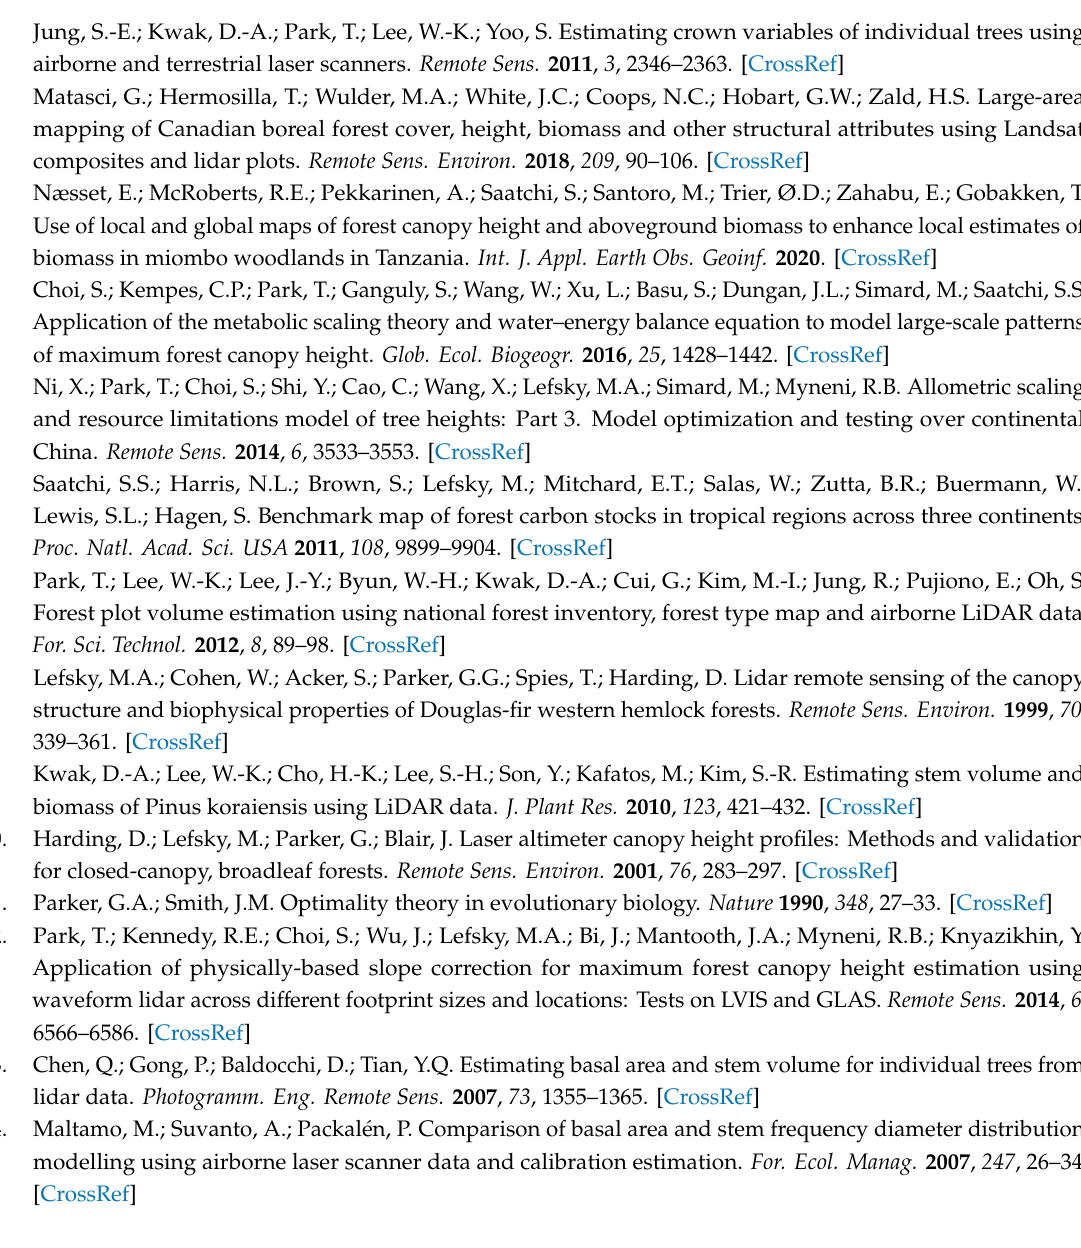
first and second canonical discriminant function. Figure S4. Evaluation of the developed plot volume models using independent testing data. Figure S5. Three dimensional view of the lidar height distribution of each species. X and Y axes are a spatial coordinate of the plot (meter scale). Figure S6. Three dimensional view of the lidar intensity distribution of each species. X and Y axes are a spatial coordinate of the plot (meter scale). Table S1. Descriptive statistics of the field measurements. Table S2. Sorted the highest accuracy results of linear discriminant analysis by number of variables. Table S3. Error matrix of plot dominant species classification results by discriminant analysis (case on the highest performance of 93.3%). Table S4. Result of plot volume parameters estimated multiple regression analysis to Larix kaempferi . Table S5. Result of plot volume parameters estimated multiple regression analysis to Pinus densiflora . Table S6. Result of plot volume parameters estimated multiple regression analysis to Quercus